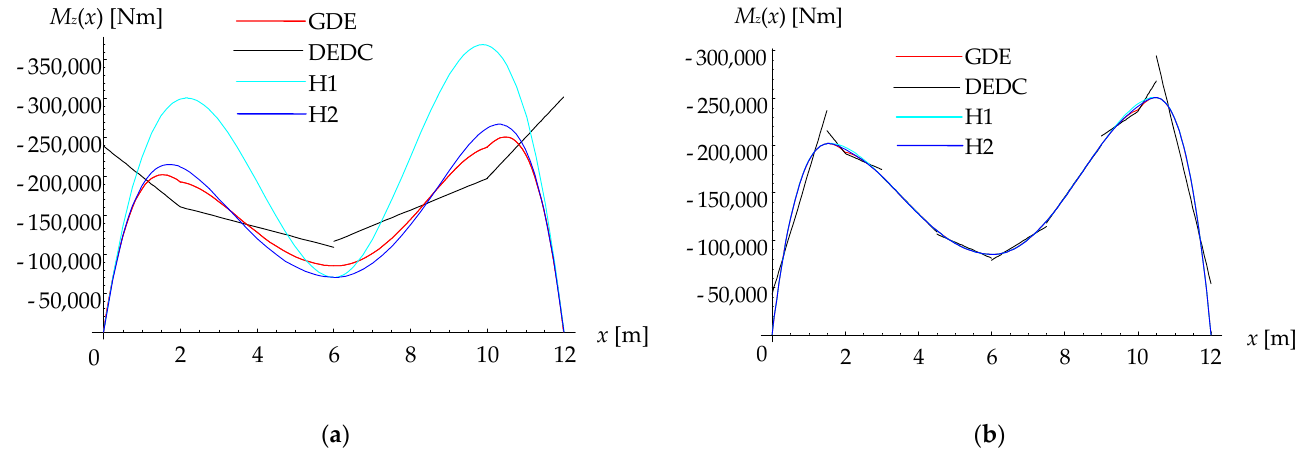
Figure 4. Comparison of bending moments for two ( a ) and eight ( b ) FE meshes, respectively.